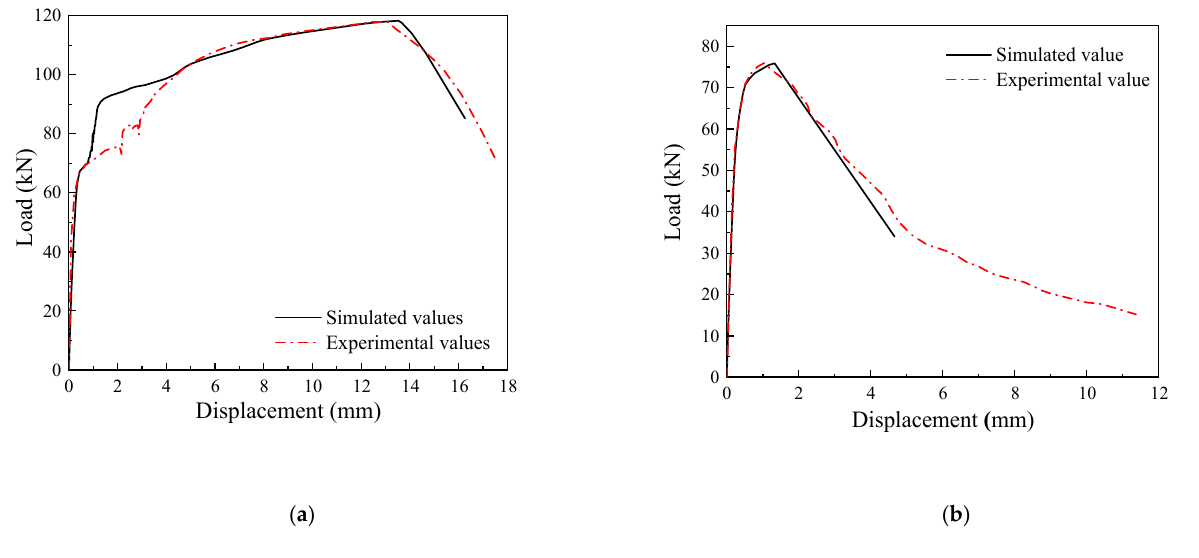
Figure 10. Comparison of load–displacement curves of grouting sleeves with and without defects. ( a ) Without defects. ( b ) With 25% defects at the end.